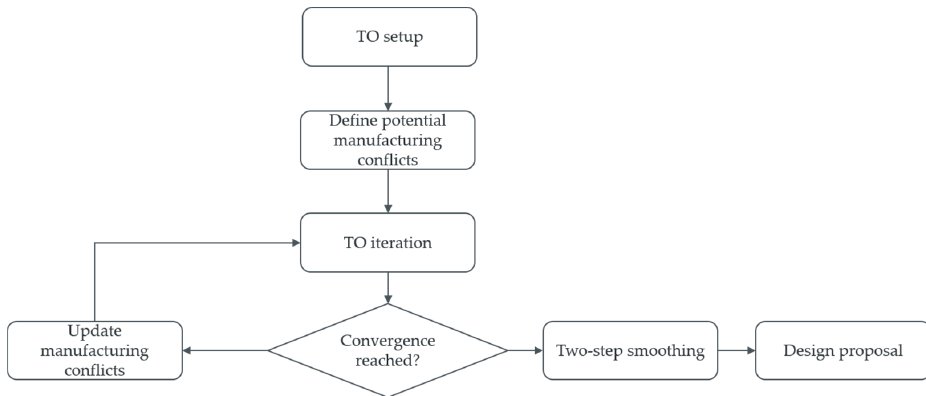
Figure 1. Overall process flow chart of the proposed method.